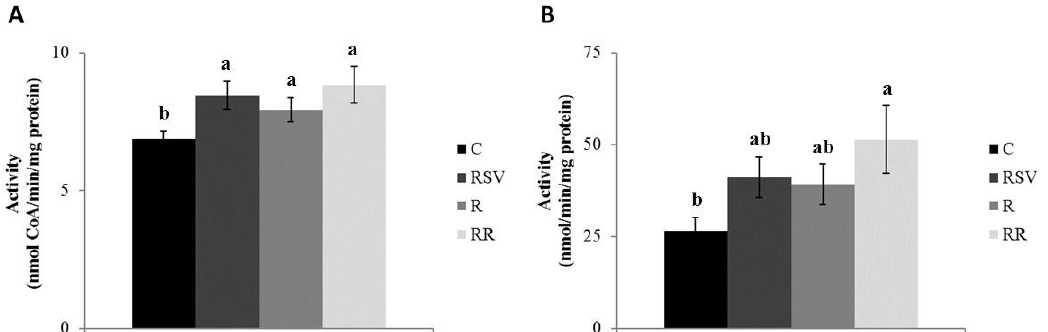
Figure 1. Activities of CPT-1a ( A ) and CS ( B ) in IBAT of rats fed an obesogenic diet for 6 weeks and then shifted to a standard diet (C), or standard diet supplemented with resveratrol (RSV), or